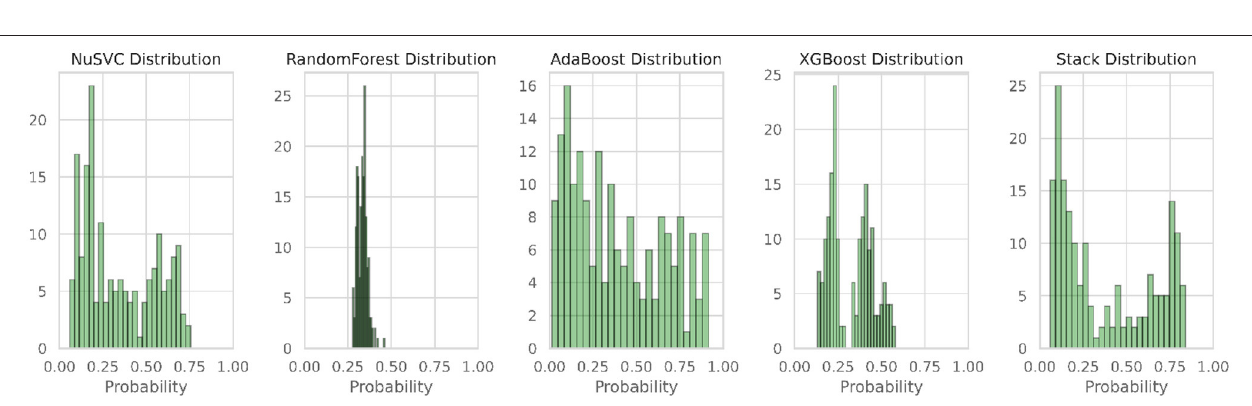
FIGURE 13 | Confusion matrix of multi-tage heterogeneous stacking ensemble classification model 2.